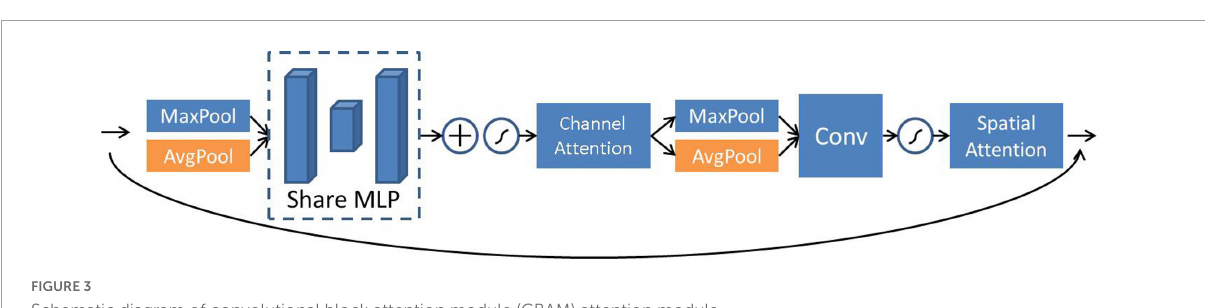
FIGURE3 Schematic diagram of convolutional block attention module (CBAM) attention module.